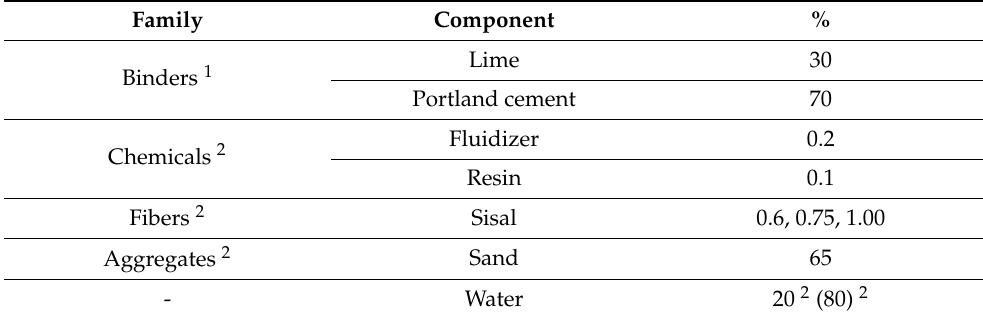
Table 2. Mixture ratio of the